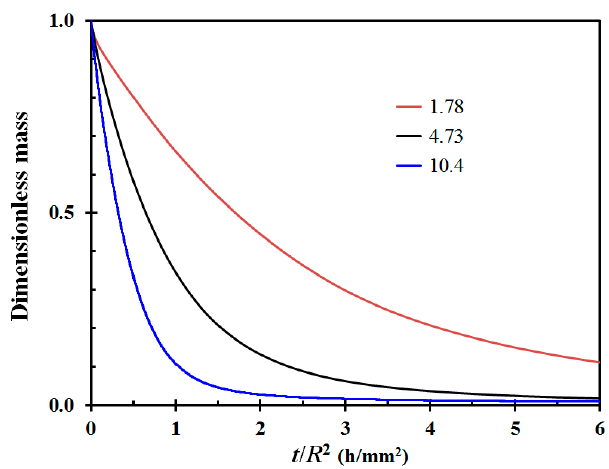
Figure 4. Dimensionless mass as a function of time normalized by the radius squared for selected low, medium and high diffusion coefficient test Calluna test specimens. The curves are labeled by their respective diffusion coefficients (in units 10 − 11 m 2 /s).